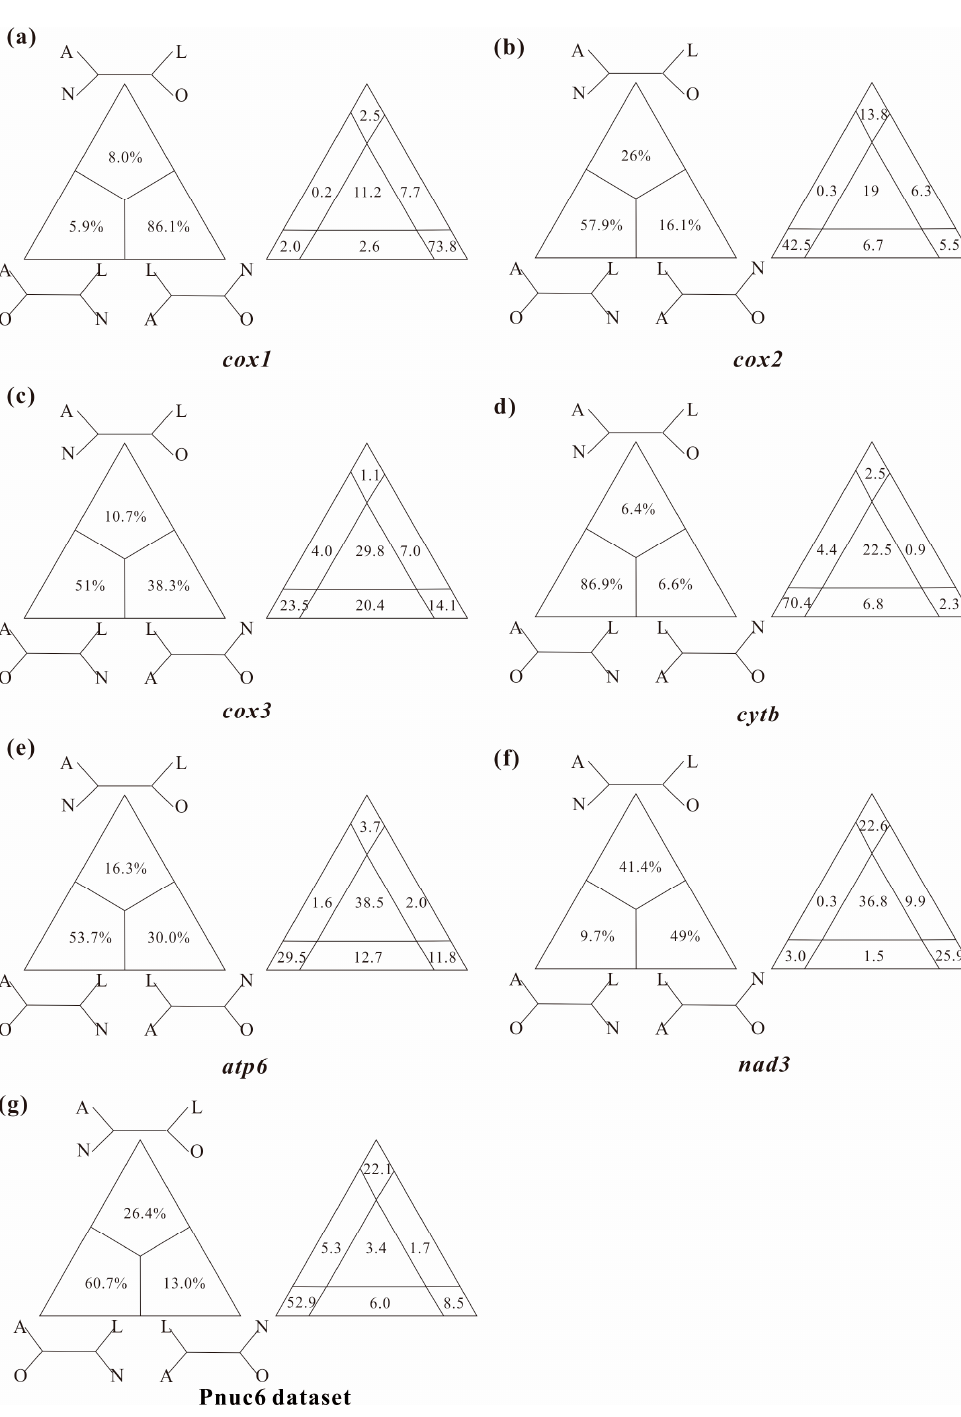
Figure 3. Conflict visualization using four-cluster likelihood mapping analyses as implemented in Treepuzzle based on the nucleotide sequence alignment of the first and the second codon positions of cox1 ( a ), cox2 ( b ), cox3 ( c ), cytb ( d ), atp6 ( e ), nad3 ( f ), and Pnuc6 dataset ( g ). Quartet proportions (in %) are mapped on a 2D-simplex graph supporting different quartet topologies on the major phylogenetic relationships within Branchiopoda.